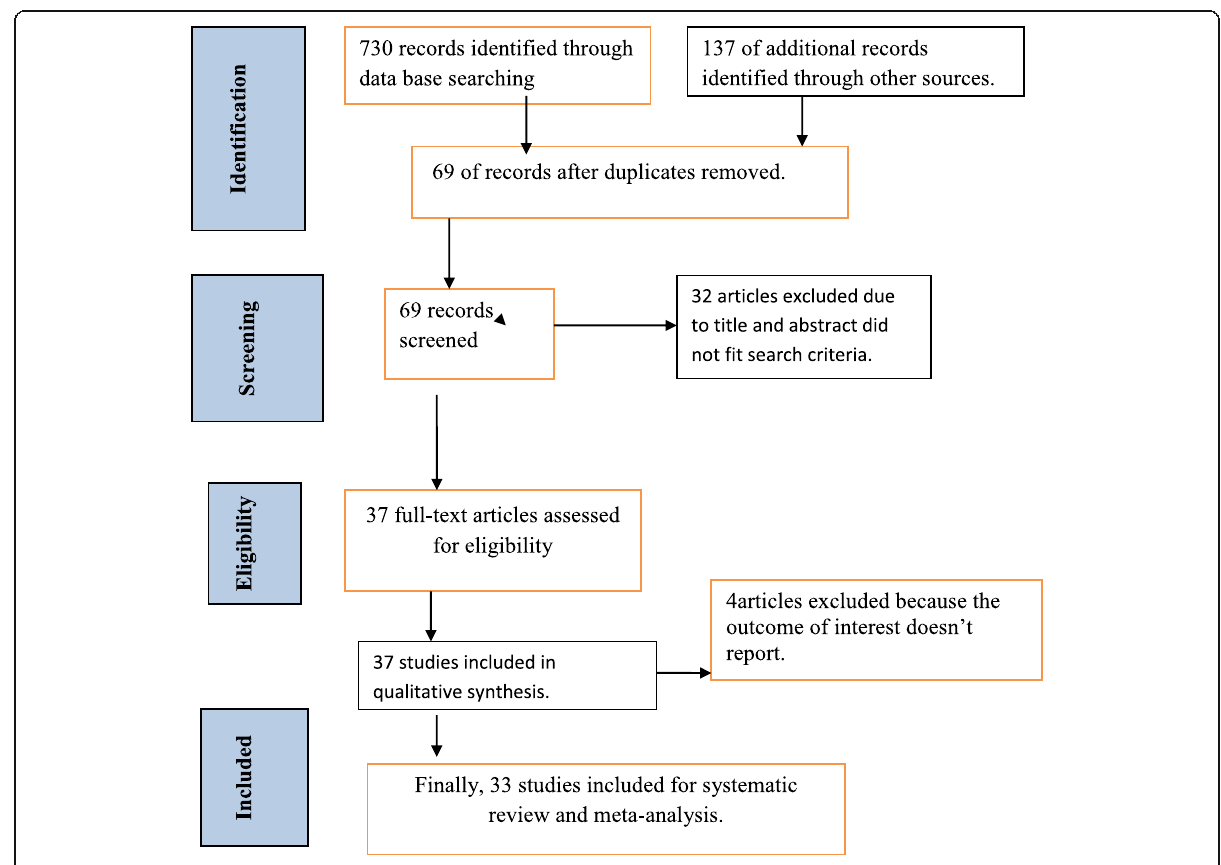
Fig. 1 Flowchart diagram of search strategy and article selection for vertical HIV infection in East Africa,